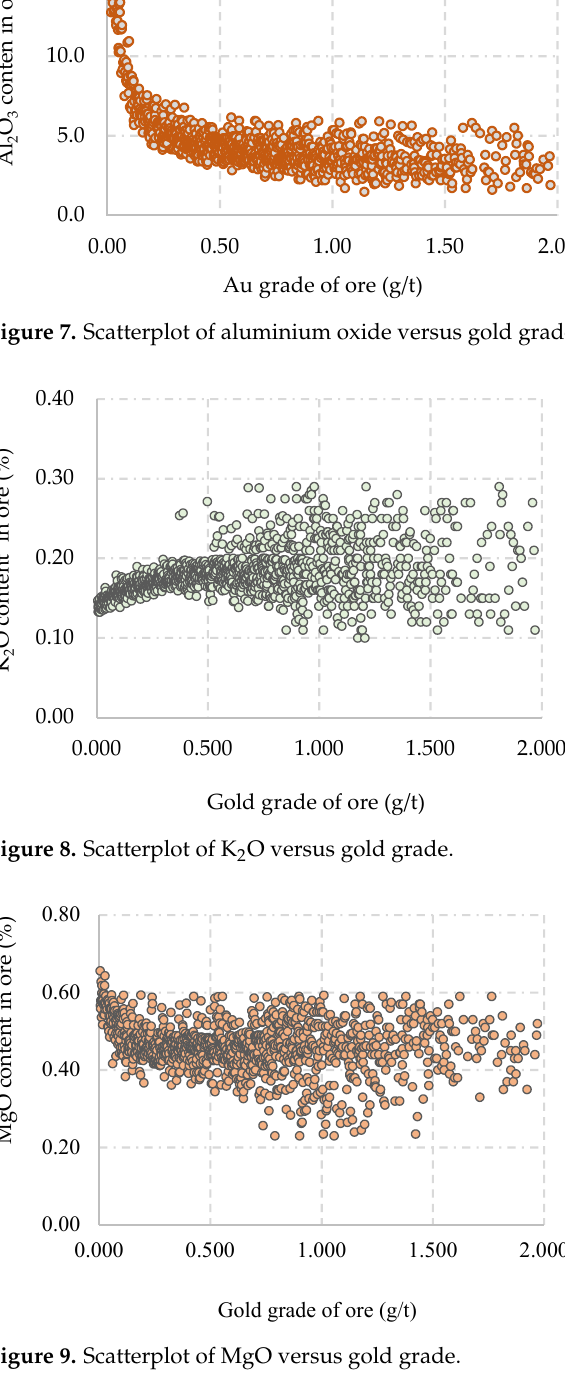
Figure 9. Scatterplot of MgO versus gold grade.